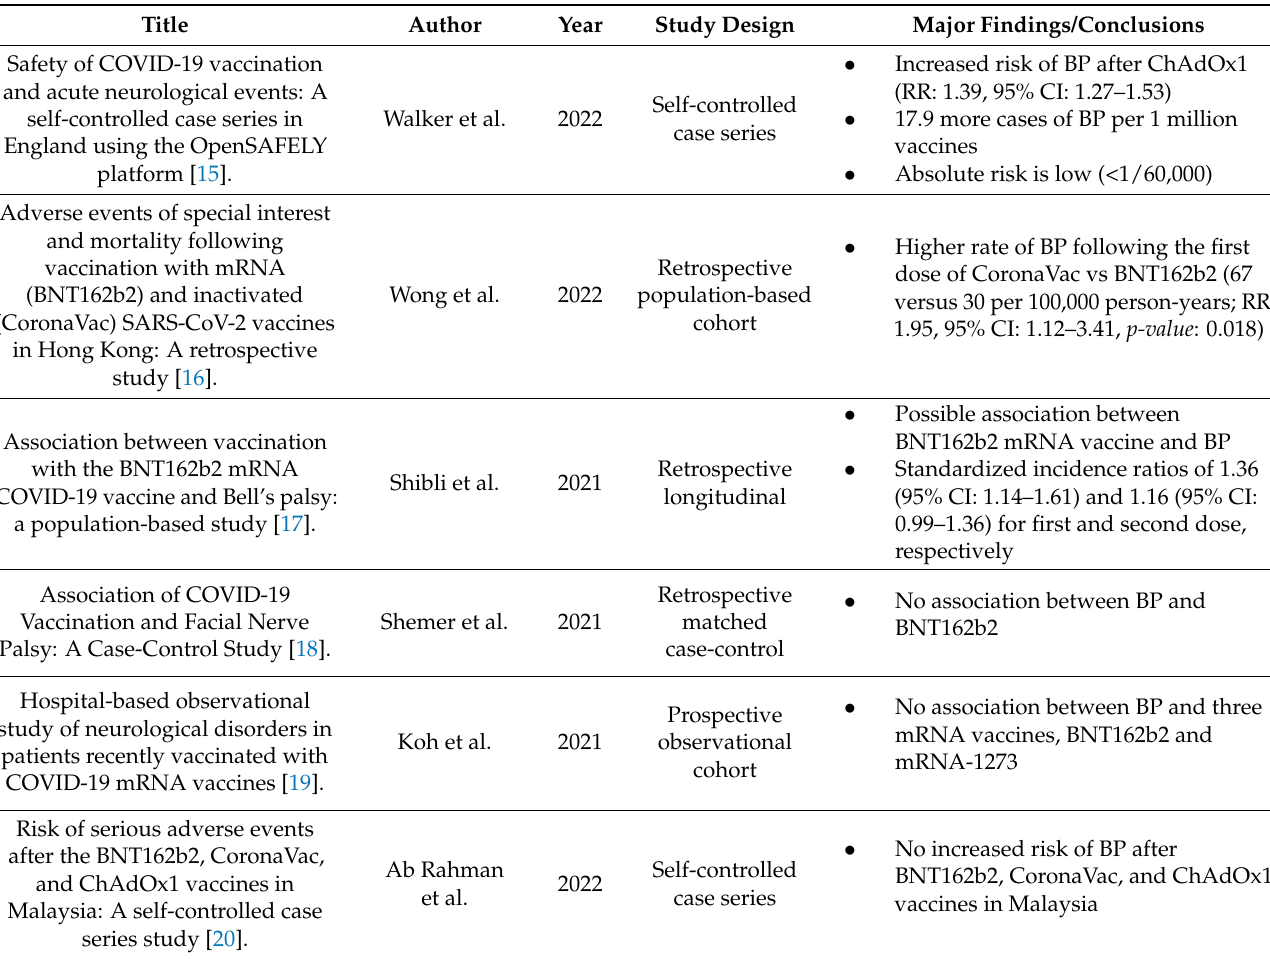
Table 2. Literature on the association between Bell’s palsy and COVID-19